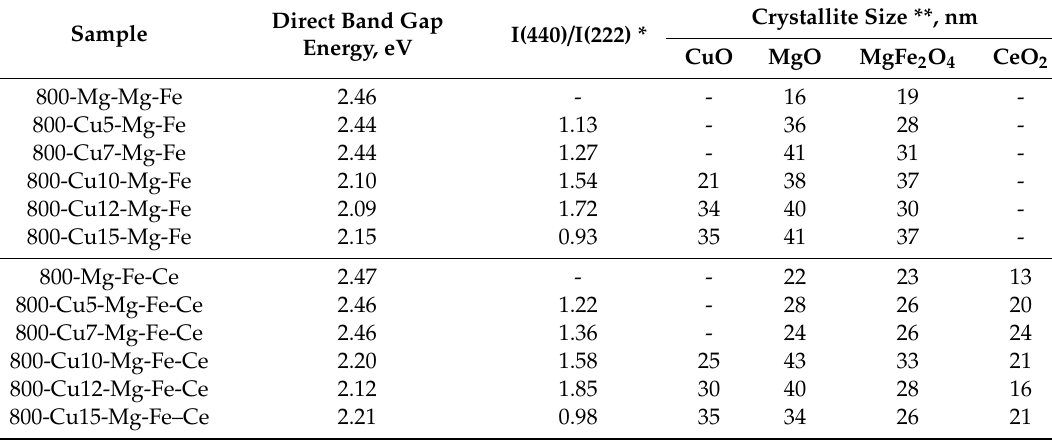
Table 5. Direct band gap energy (eV), crystallite sizes (nm) and XRD intensity ratios for Cu-Mg-Fe-O and Cu-Mg-Fe-O-Ce mixed metal oxides. Crystallite Size **, Direct Band Gap Sample I(440) / I(222) * Energy, eV